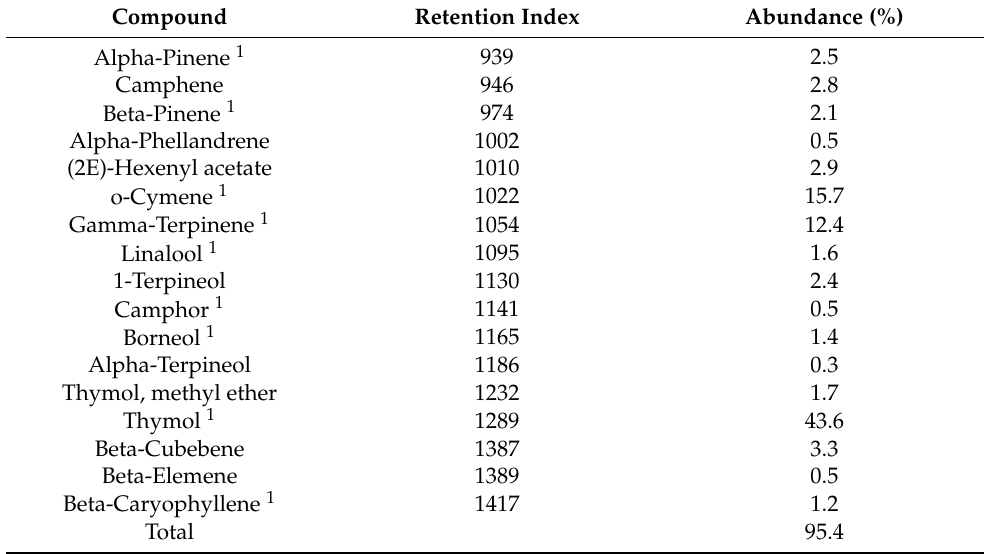
Table 1. Chemical profile of the leaf essential oil from Thymus vulgaris obtained in Puebla-M é xico